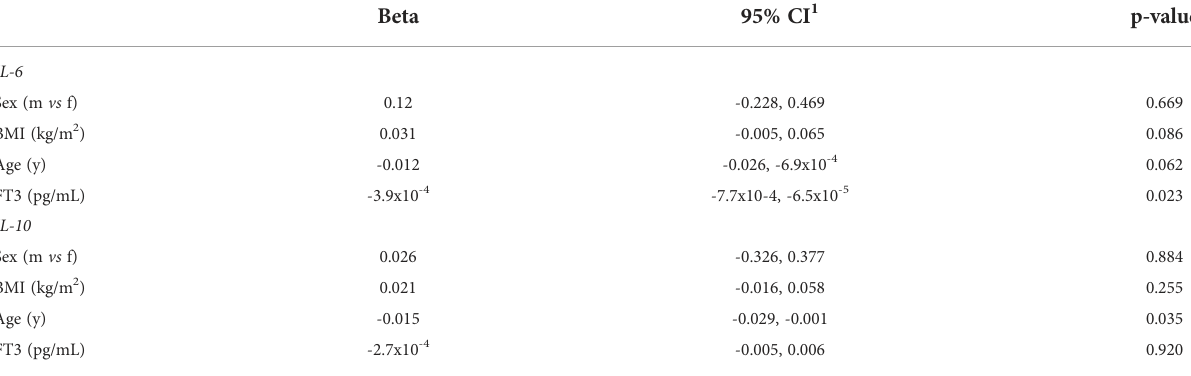
TABLE 7 Multivariate linear regression analysis of IL-6 and IL-10 according to FT3 with adjustment for age, sex, and BMI in ward hospitalized COVID-19